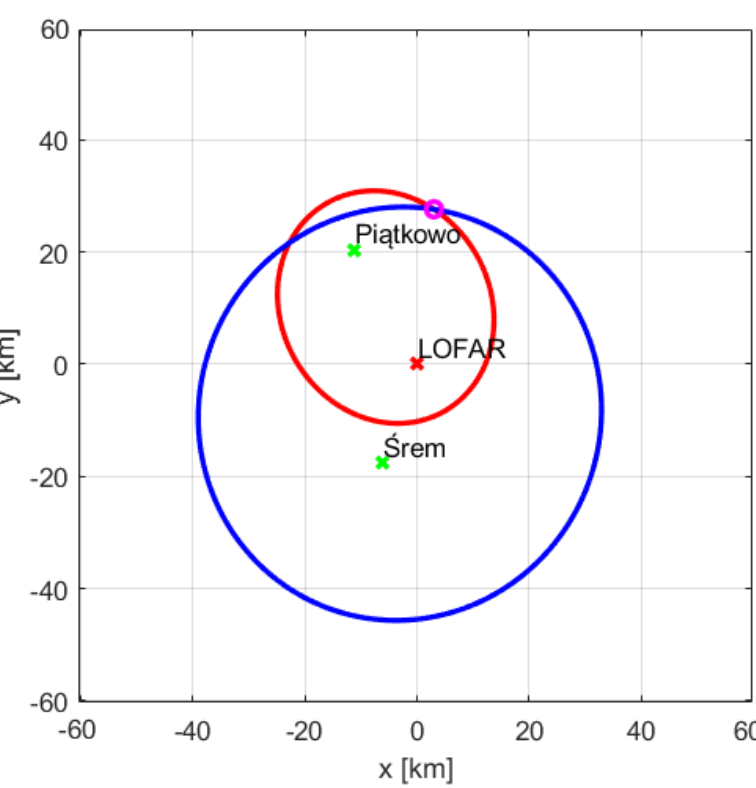
Figure 14. Intersection of ellipses for